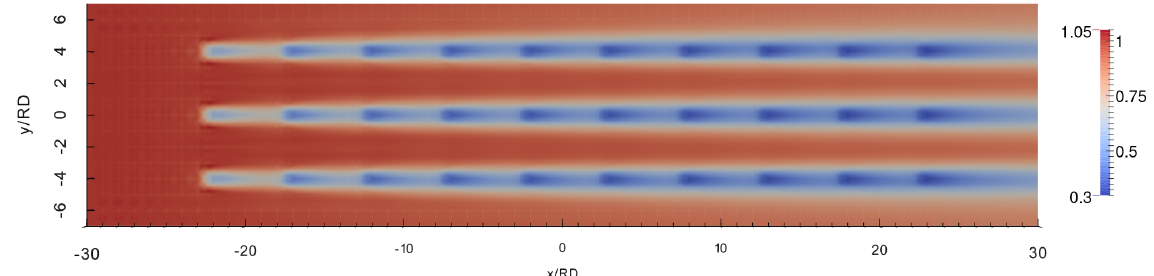
Figure 5. Hub-height velocity fields from the 3-D RANS solver used in WindSE show good qualitative agreement with time-averaged LES velocity fields of similar wind plants reported in the literature (Wu and Porté-Agel, 2013), even in the case of very deep wind plants. Velocities are normalized by incoming hub-height speed of 8ms − 1 and distances are normalized by the 80m rotor